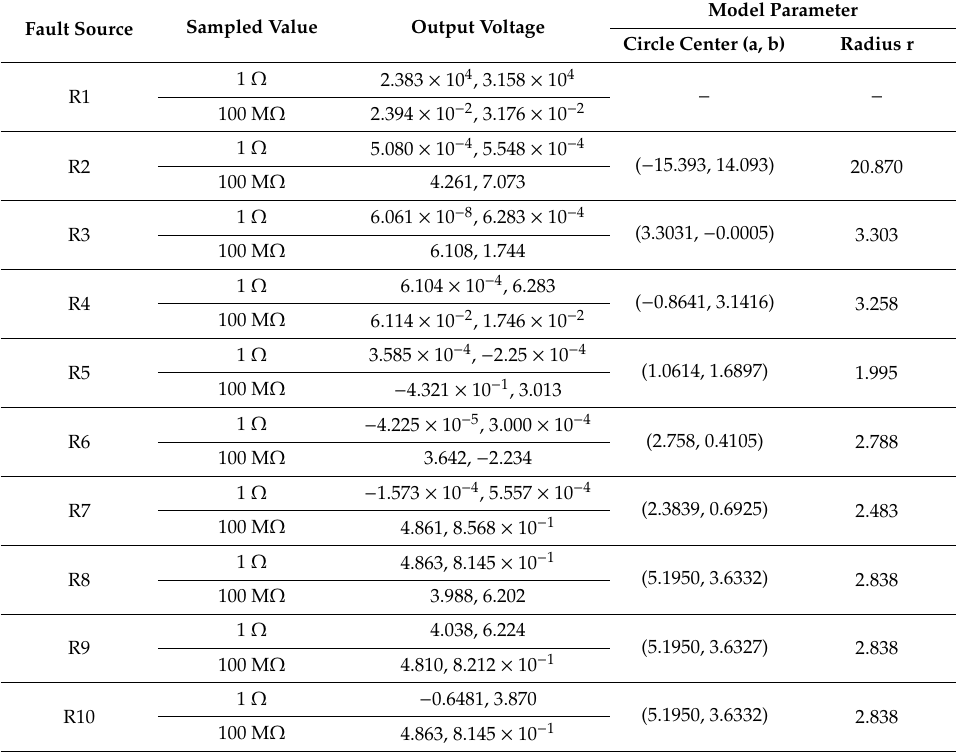
Table 1. Fault model parameter of the Leapfrog